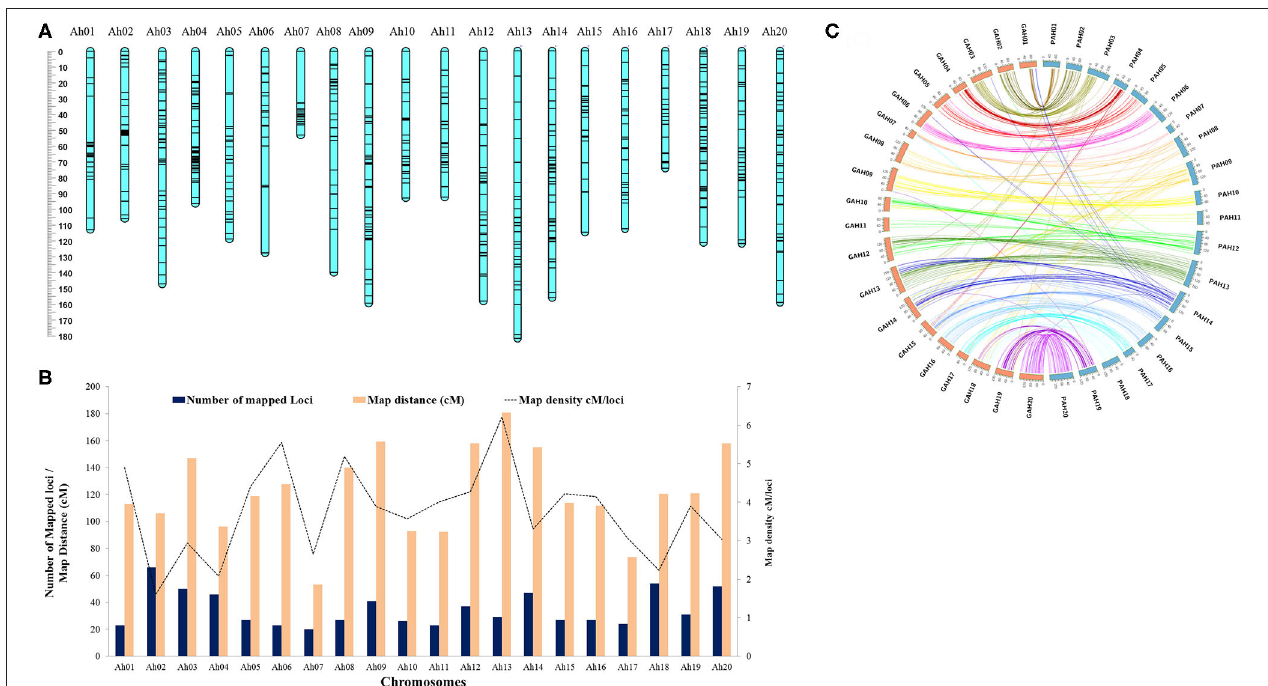
FIGURE 2 | High density genetic map of RIL population of TMV 2 and TMV 2-NLM. (A) Map chart of high density genetic map. (B) Summary of genetic map with number of mapped loci, map distance (cM), and map density (cM/loci). (C) Collinearity of the genetic map with the reference genome ( Arachis hypogaea L.). Prefix G and P stands for genetic map and physical map,